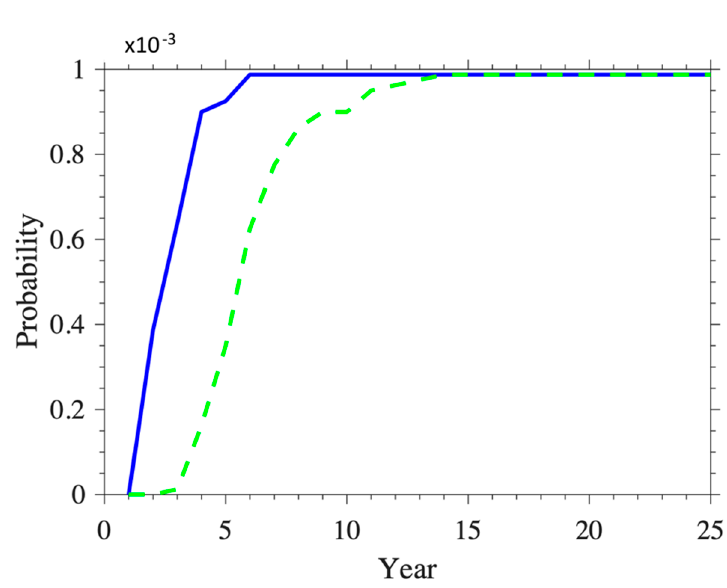
Figure 7. Probability of failure with the two limit states (blue: g; dashed green: g ′ ).